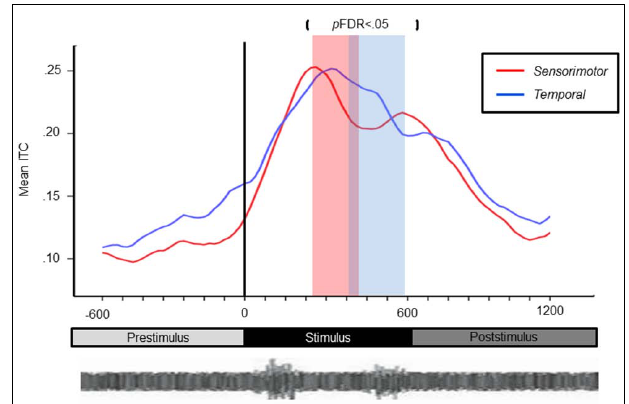
FIGURE 7 | Line chart depicting earlier peak responses in the left- sensorimotor clusters relative to temporal lobe clusters for correct syllable discrimination trials. Sensiromotor cluster shown in red with the temporal cluster shown in blue. Significance for the contrast correct > chance are marked in the red column for the sensorimotor cluster and blue for the temporal lobe